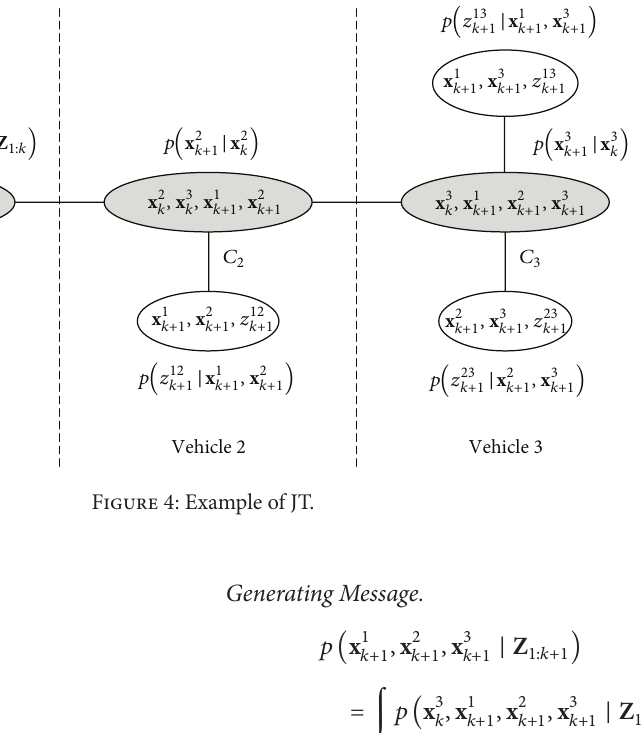
Figure 4: Example of